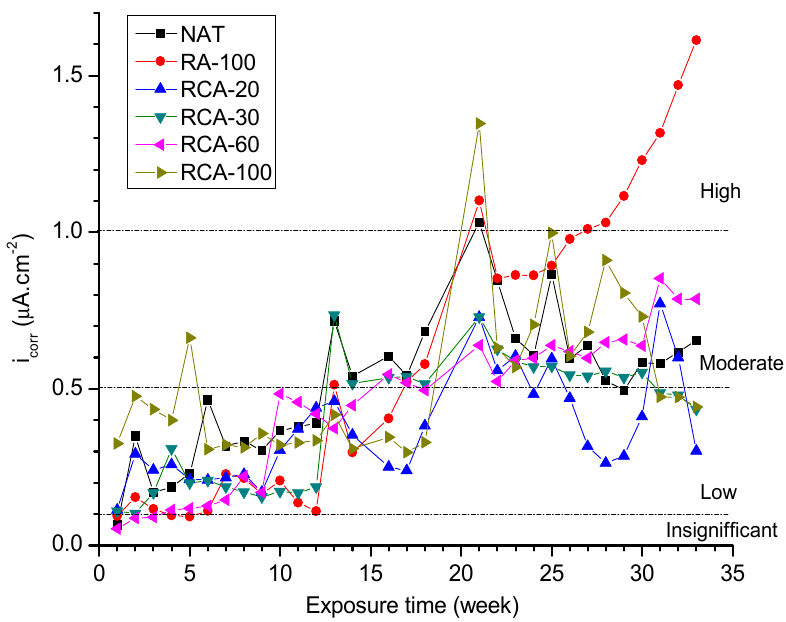
Figure 11. Evolution of i corr for mixtures with RFA.